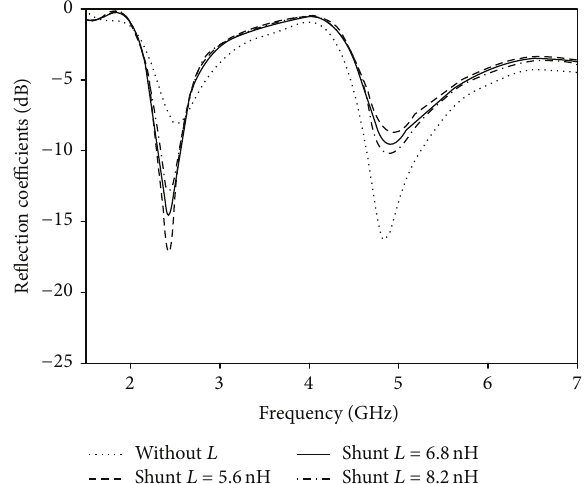
Figure 3: Simulated reflection coefficients of the proposed antenna as a function of the chip inductor ( 𝐿 ).